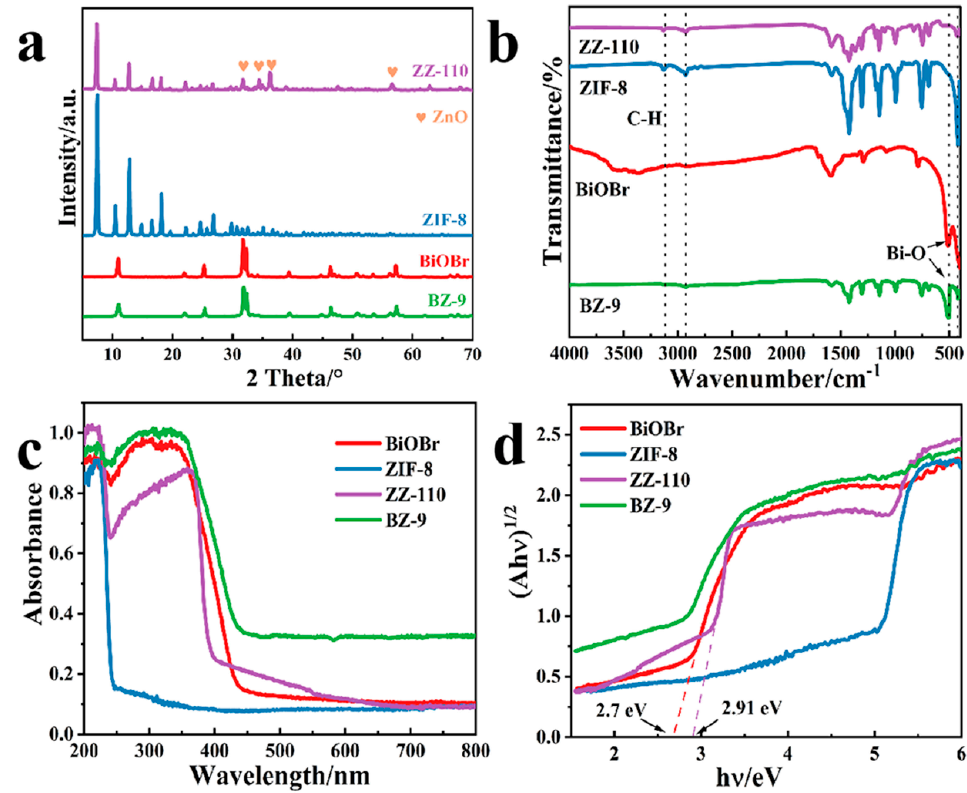
Figure 1. ( a ) XRD patterns of BiOBr, ZIF − 8, ZZ − 110, and BZ − 9; ( b ) FTIR spectra of the prepared samples; ( c ) UV − vis diffuse reflectance spectra; ( d ) The band gaps of BiOBr, ZIF − 8, ZZ − 110, and BZ − 9.